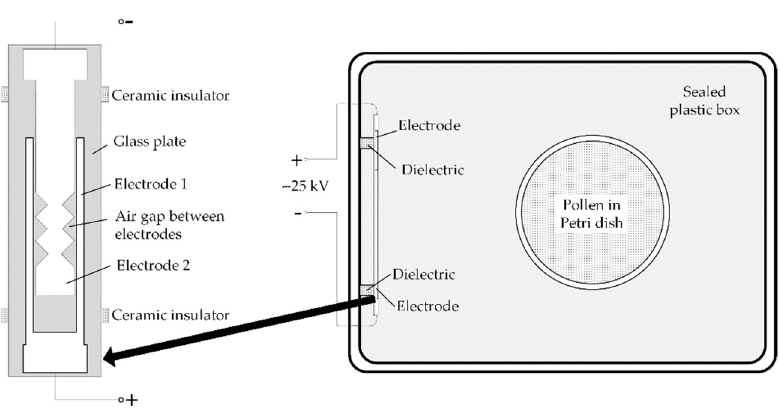
Figure 1. Pollen sample exposure to O 3 experimental set-up and high voltage electrical discharge system configuration.